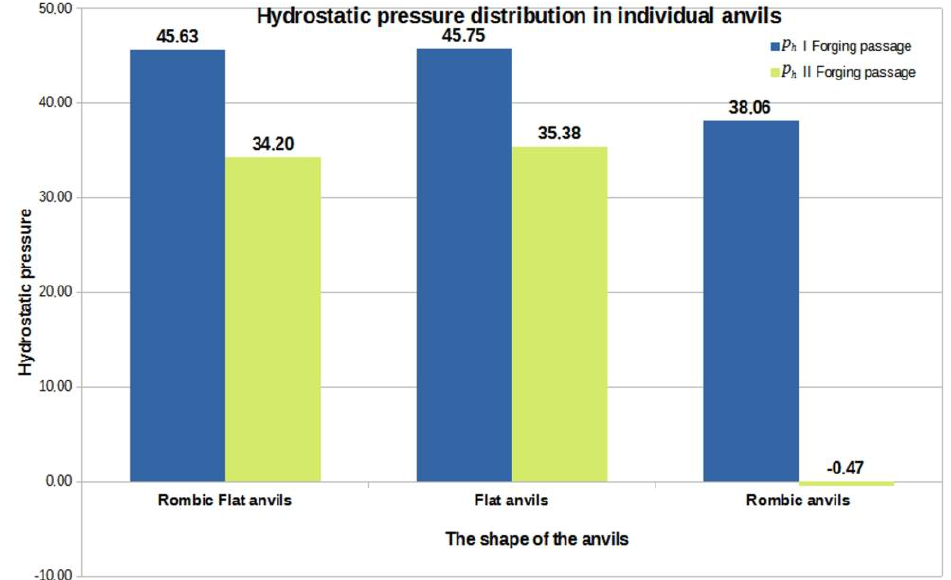
Figure 16. The graph of the arithmetic mean value of the hydrostatic pressure around the unwelded discontinuities in relation to the individual anvil compositions.